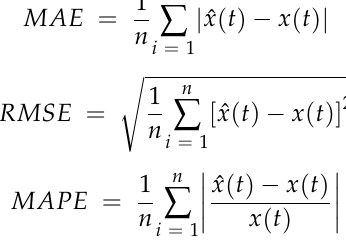
Figure 5. The results of EMD method ( a ) Yan’an; ( b ) Huashan.